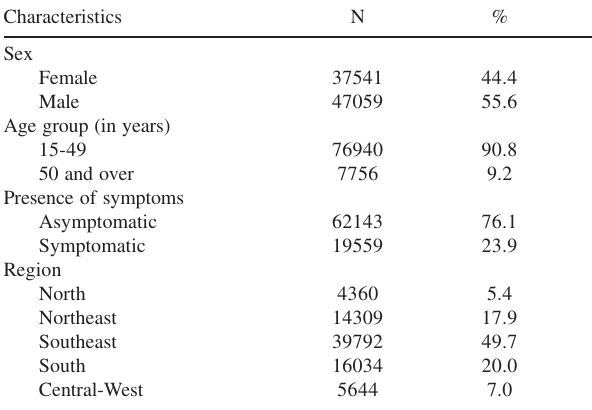
Table 1 - Distribution of treatment-naïve patients by sex, age, presence of symptoms, region of residence and year of exam request. Brazil, 2003-2006.